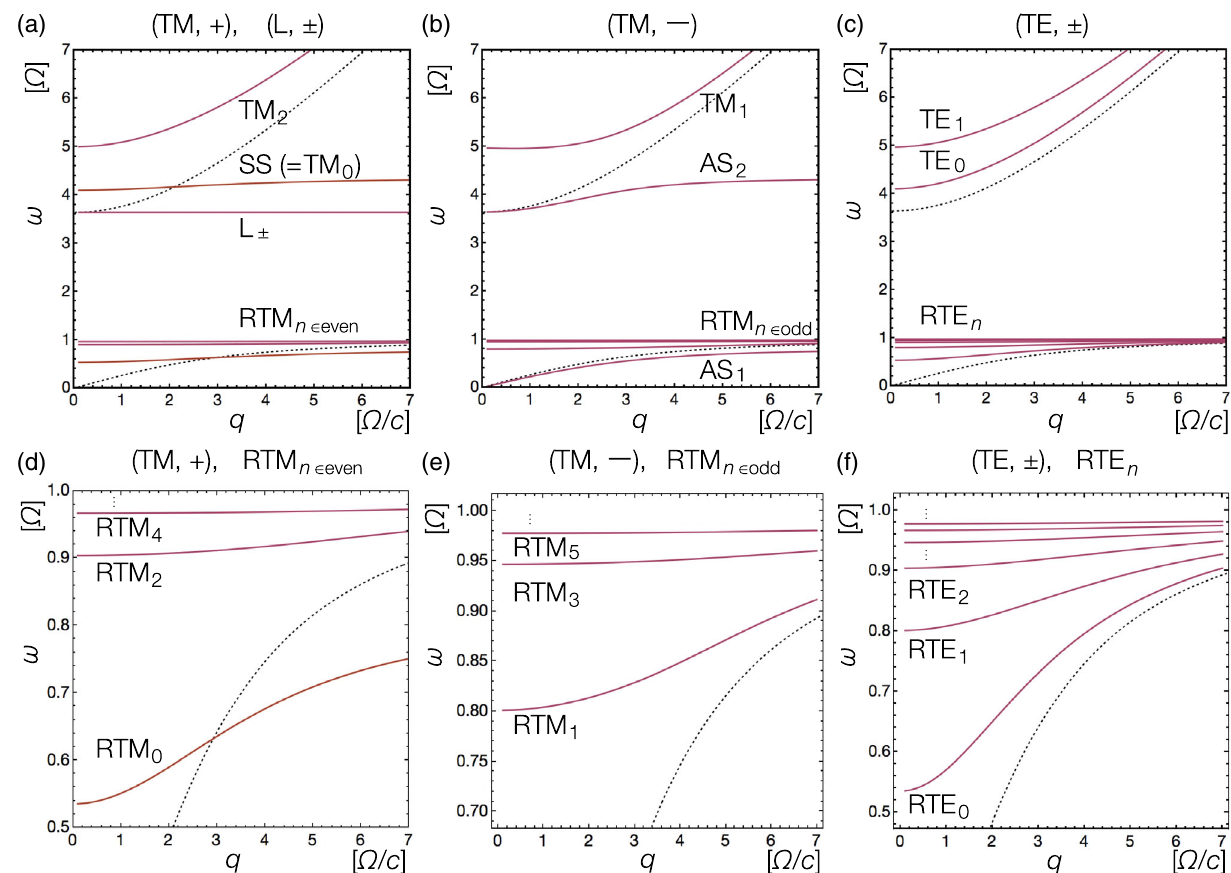
FIG. 6. Elementary excitations of the cavity setting in different sectors ð Λ ; P Þ with Λ ¼ TM, TE, L denoting the transverse magnetic (TM), transverse electric (TE), or longitudinal (L) polarization and P ¼ (cid:3) being the parity of transverse components of the electric field against the inversion of the direction perpendicular to the plane. Black dotted curves indicate the bulk dispersions. The top plots excitation energies ω against in-plane momentum q in the sectors (a) (TM ; þ ) and (L ; (cid:3) ), (b) (TM ; − ), and (c) (TE ; (cid:3) ), respectively. The bottom (d) – (f) show the corresponding magnified views below the phonon frequency Ω . In (a) and (b), the TM 1 two highest modes in the TM sector; the SS ( ¼ TM 0 ) mode represents the symmetric surface (SS) mode, and the AS 1 the antisymmetric surface (AS) modes whose dipolar moments point out of the plane at low q . The longitudinal L nondispersive energy independent of the momentum q and the parity P ¼ (cid:3) . The assignment of the label TM 0 to the SS mode is in accordance with the convention used in studies of plasmonics [148]. In (d) and (e), the RTM resonant TM modes close to the dipolar-phonon frequency Ω . The RTM softened mode RTM 0 is essentially the surface mode localized at the interfaces analogous to the SS mode. In (c), the TE 0 represent the two highest modes in the TE sector. In (f), the RTE extend over the insulator region. The parameters are d ¼ c= Ω , g ¼ 3 . 5 Ω , and ω frequency is set to be a rather low value, while its specific choice does not qualitatively affect the thermodynamic